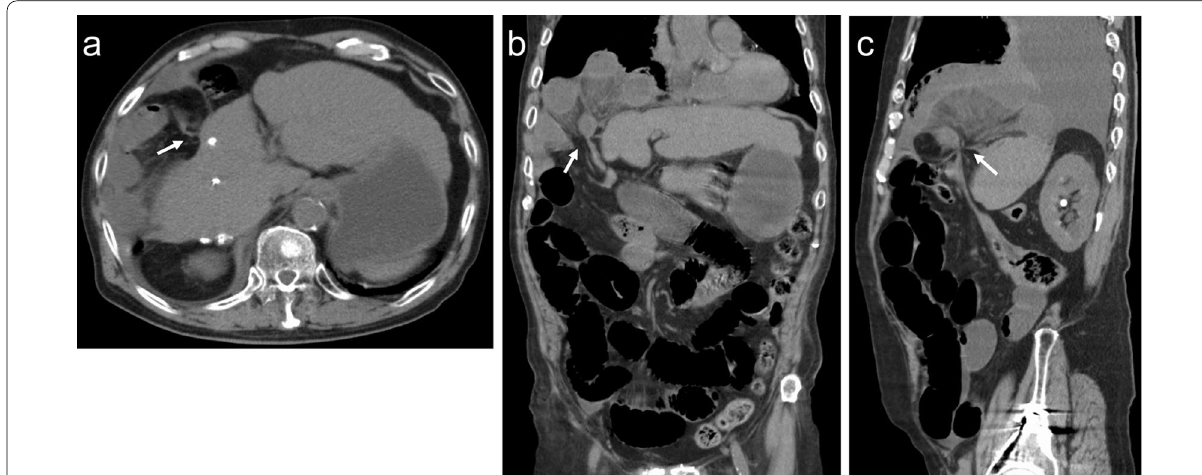
Fig. 3 CT image. a Axial view, b coronal view, c sagittal view. The small intestine herniated through the right diaphragm with intestinal expansion (arrow). Pleural effusion was observed in the right chest cavity